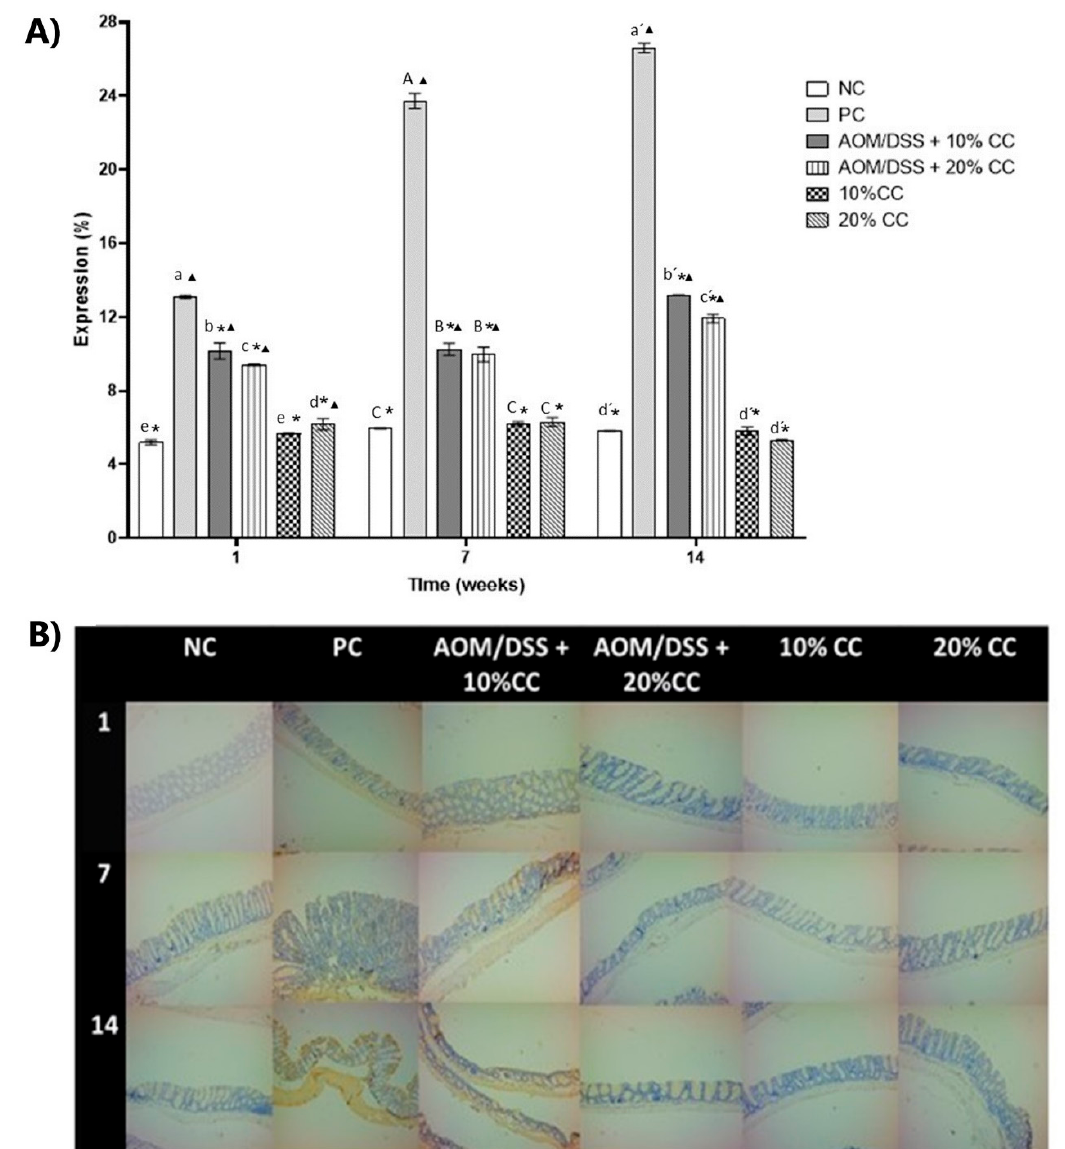
Figure 6. ( A ) Percentage of 4-hydroxy-2-nonenal (4-HNE) expression in the distal portion of the colon of BALB/c mice administered with AOM/DSS in three periods. ( B ) Representative images of the histology of the colonic mucosa by immunohistochemistry in the distal portion on Weeks 1, 7, and 14. Magnification 10x. Lowercase letters correspond to Week 1, uppercase letters correspond to Week 7, and raw letters correspond to Week 14. * means significant difference from the PC in the same evaluation week and ▲ significant difference with respect to the NC in the same evaluation week. One-factor ANOVA ( p < 0.05), Dunnett’s test. Different letters indicate significant difference ( p < 0.05) in the same evaluation week by Tukey’s test. Values are presented as the means ± S.D. from three experimental replicas.